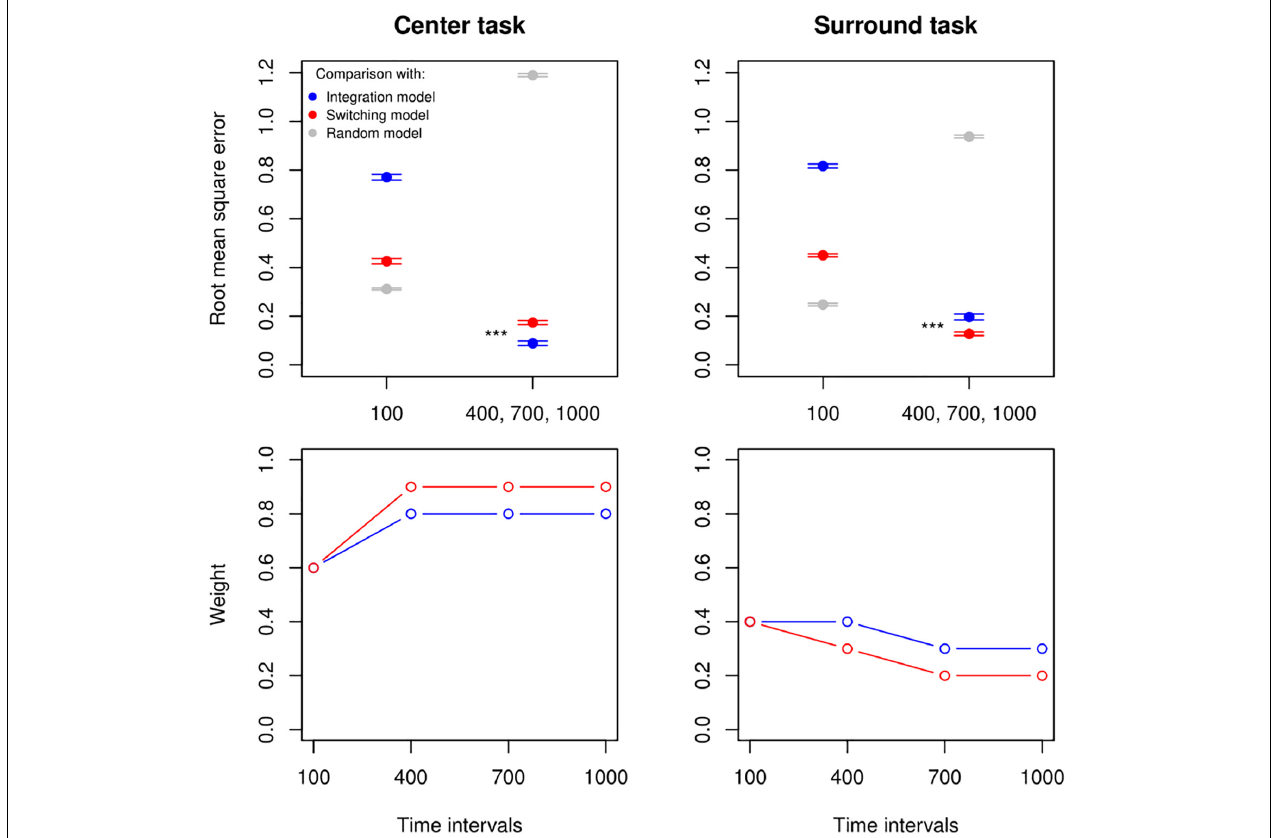
FIGURE 4 | Observer simulations and optimal weights. Top panel: a comparison using the root-mean squared error between empirical data from the centre and surround conditions (left and right plot, respectively) and simulated data with varying combination rules (Integration in blue, Switching in red, and Random choice in grey). Ten datasets were simulated for 9 weight values (from 0.1 to 0.9) and for each rule. In both plots the lowest RMSE values across all weights at the 100 ms interval for all combination rules (and their standard errors across the 10 simulations) are shown on the left, while the mean and standard errors of the lowest RMSE values averaged across the remaining intervals are shown on the right. Bottom panel: pattern of weight values yielding the lowest RMSE at each timing and for Integration Model (in blue) and Switching Model (in red) when compared to empirical data (left: centre task, right: surround task). *** p <